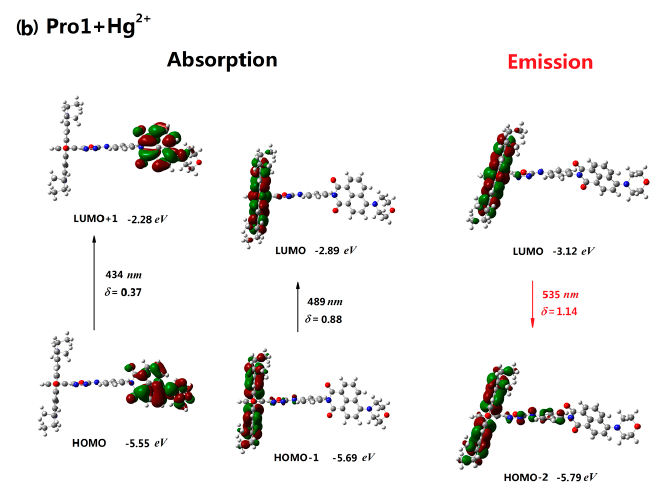
Figure 3. The absorption and emission of ( a ) Pro1 and ( b ) Pro1+Hg 2+ in H 2 O.